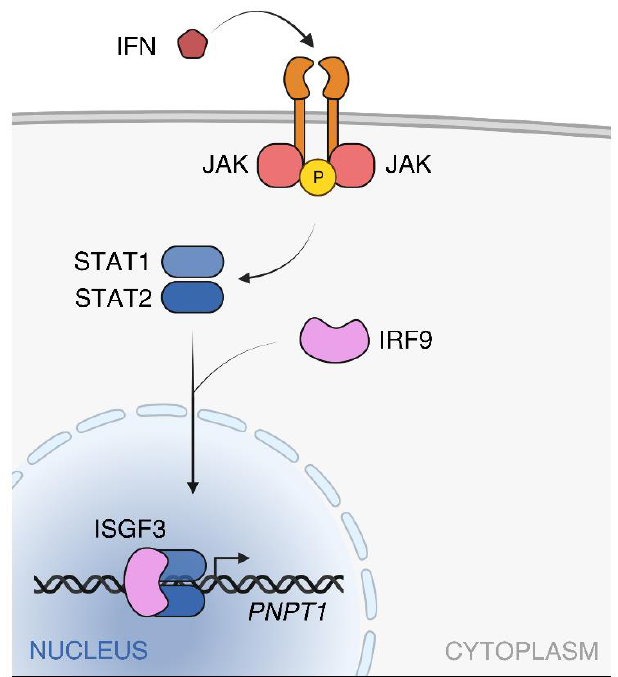
Figure 1. PNPT1 transcription induction by type I interferon. IFN- β and INF- α (IFN) induce the JAK-STAT signaling cascade described in the text leading to PNPT1 transcription activation by ISGF3. STAT2/IRF9 complex, which could also bind the ISRE, is not shown. Created with Biorender.com. Available online: https://biorender.com (accessed on 27 January 2022).